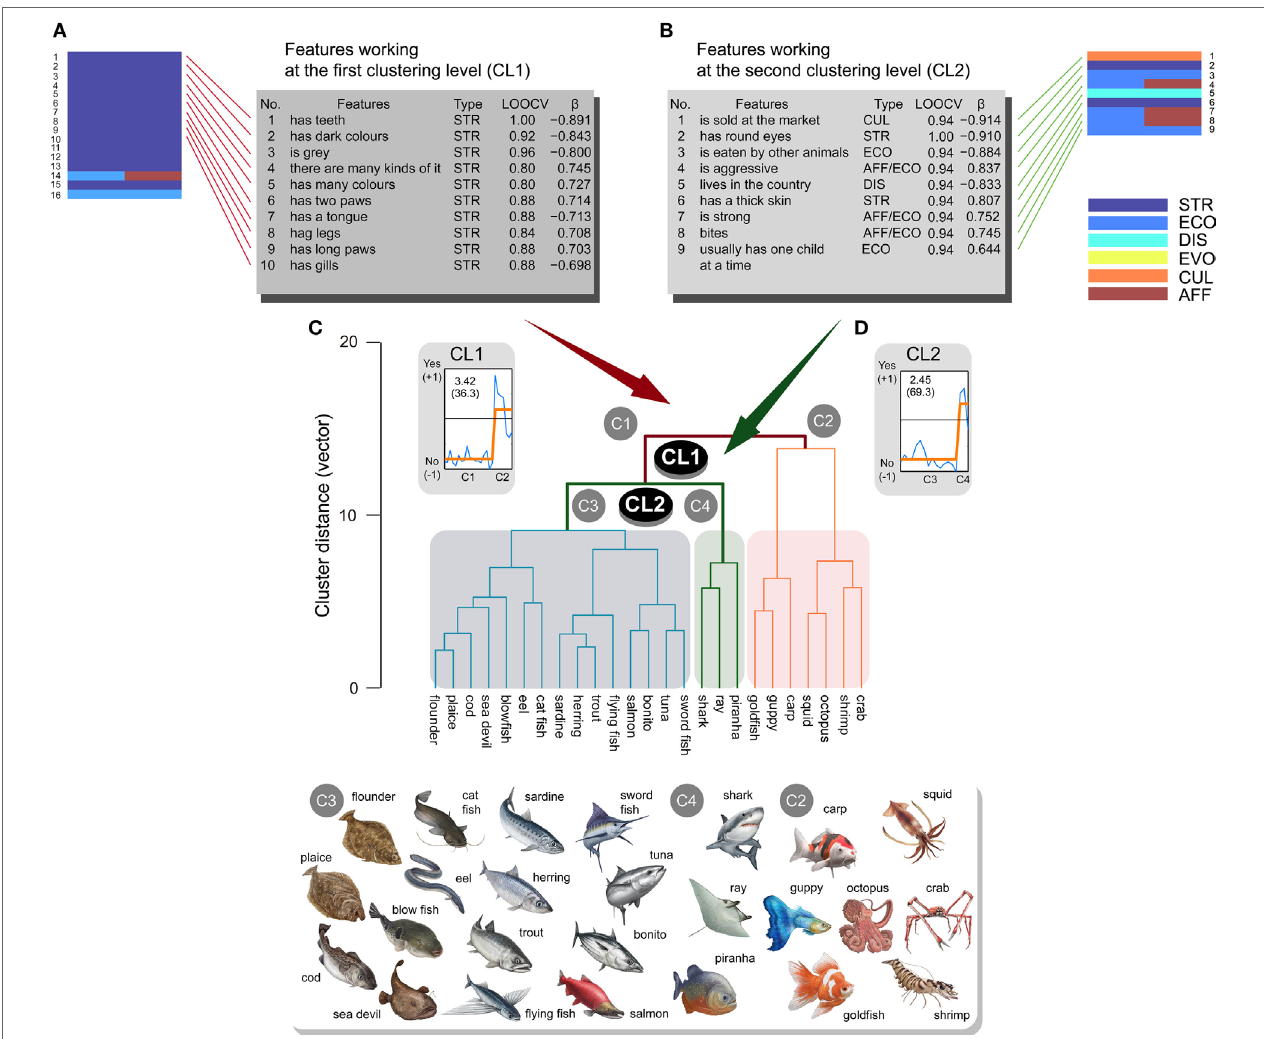
FigUre 5 | Sub-ordinate animal classification ( n = 25) for the complex fish class and related features ranked within the top 10. Animals were separated into two major clusters (C1, C2) at the first clustering level (CL1). The first cluster (C1) was separated into two clusters (C3, C4) at the second clustering level (CL2). Features ranked within the top 10 are listed for CL1 (a) and CL2 (B) (STR, structural; ECO, ecological; DIS, distributional; EVO, evolutional; CUL, cultural; AFF, affective) from significant features represented by brick charts. These features possessed high classification accuracies in leave-one-out cross-validation (LOOCV) tests and good fitting properties ( β ) to sigmoid-shaped binary response functions for CL1 (c) and CL2 (D) , respectively. Higher scores on the LOOCVs indicate higher classification accuracy, and more positive and larger β coefficients represent better fitting properties. All the illustrations of animals are copyrighted by M/Y/D/S Graphics (Yokohama, Japan), which permitted us to reproduce all illustrations in the manuscript.